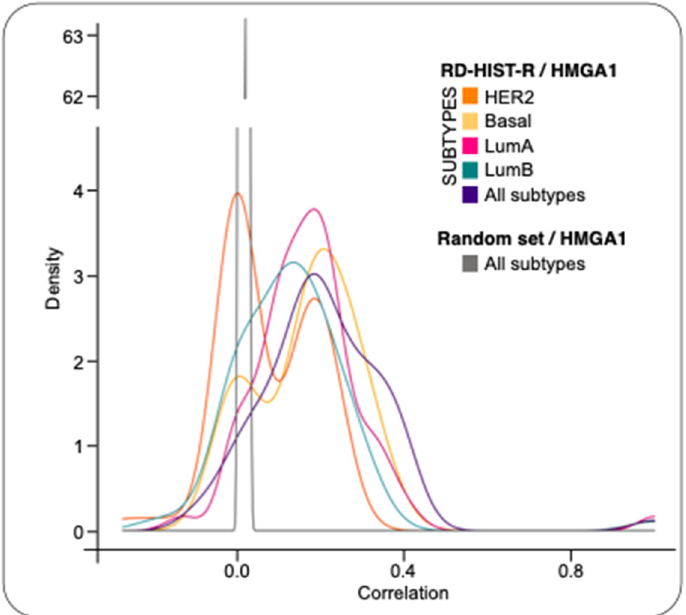
Figure 1. Correlation between HMGA1 and RD-HIST-R genes on different BC subtypes. Distribu- tions of correlation values between HMGA1 and RD-HIST-R genes in each subtype, compared to randomly selected non-histones genes as control. ECDFs were generated for each subtype and their corresponding control random sets.